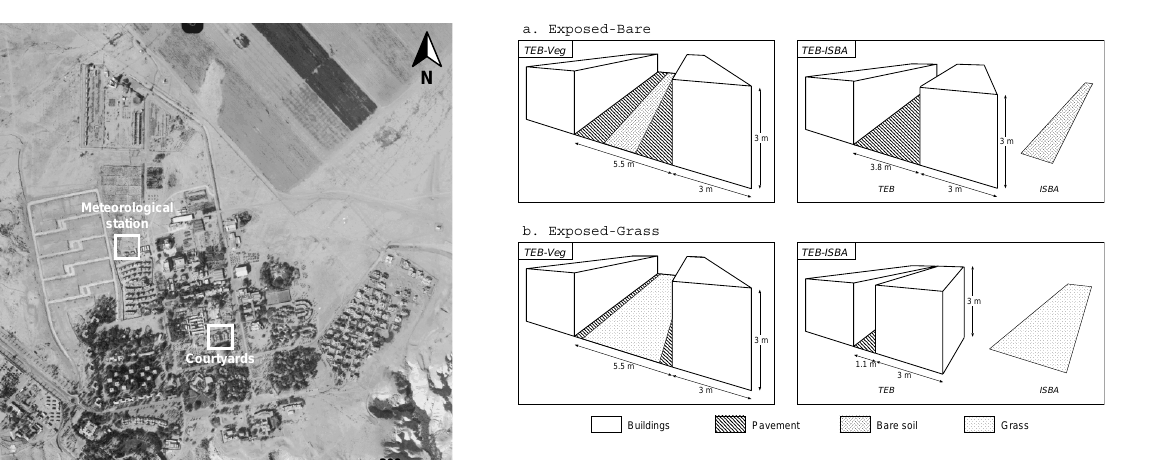
Fig. 4. Schematic of the simplified urban canyon as described in TEB-Veg (left) and TEB-ISBA (right) to represent the experimental site for the Exposed-Bare and Exposed-Grass